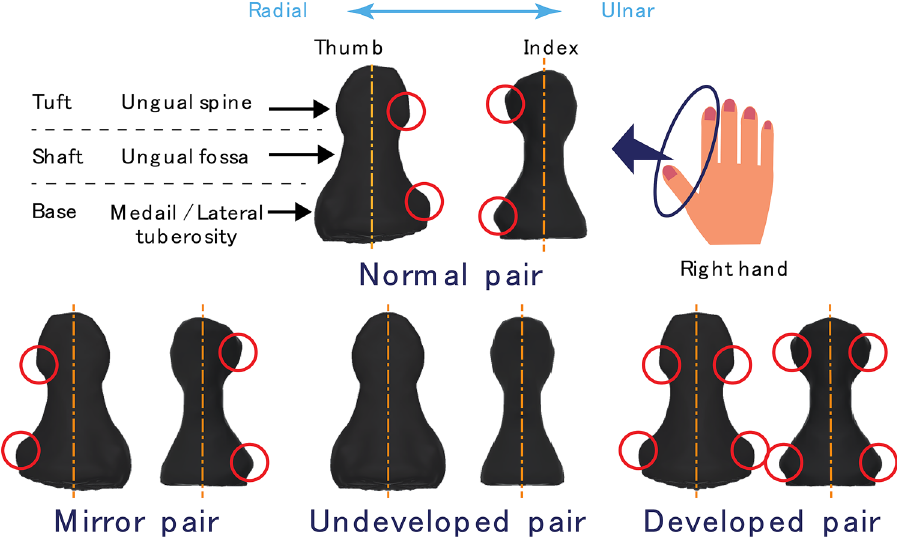
Figure 1. Tested pairs of thumb and index fingertips. The upper row shows a thumb and index distal phalanx of the right hand. Ulnar side of the thumb and radial side of the index finger exhibits ungual spine and medial tuberosity. Additionally, as shown in lower row, we prepared three pairs for comparing the precision grasping ability. The characteristics of the mirror pair are developed on the opposite side of the normal one. Undeveloped pair does not exhibit the developed characteristics on either side. Developed pair exhibits developed characteristics on both sides.